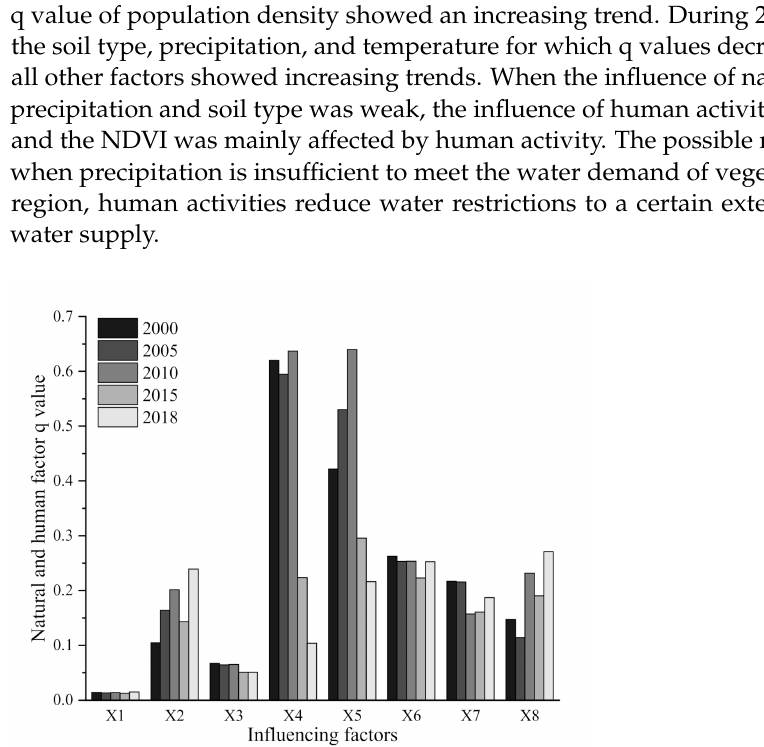
Figure 5. Changes in natural and human factors q value from 2000 to